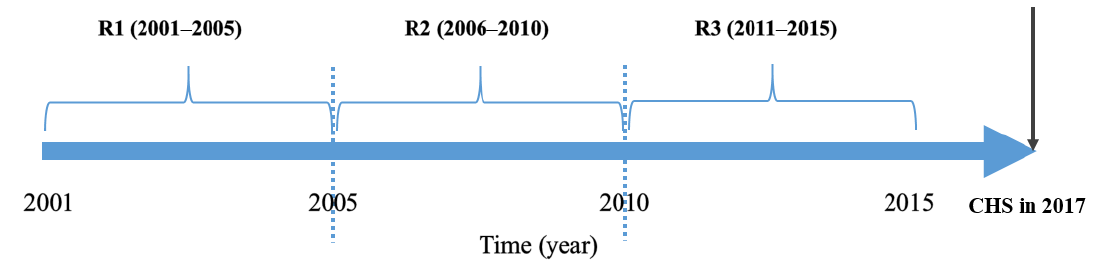
Figure 1. Study design applying a periodic window for exposure of particulate matters and residence period using Community Health Survey data in 2017, Korea.